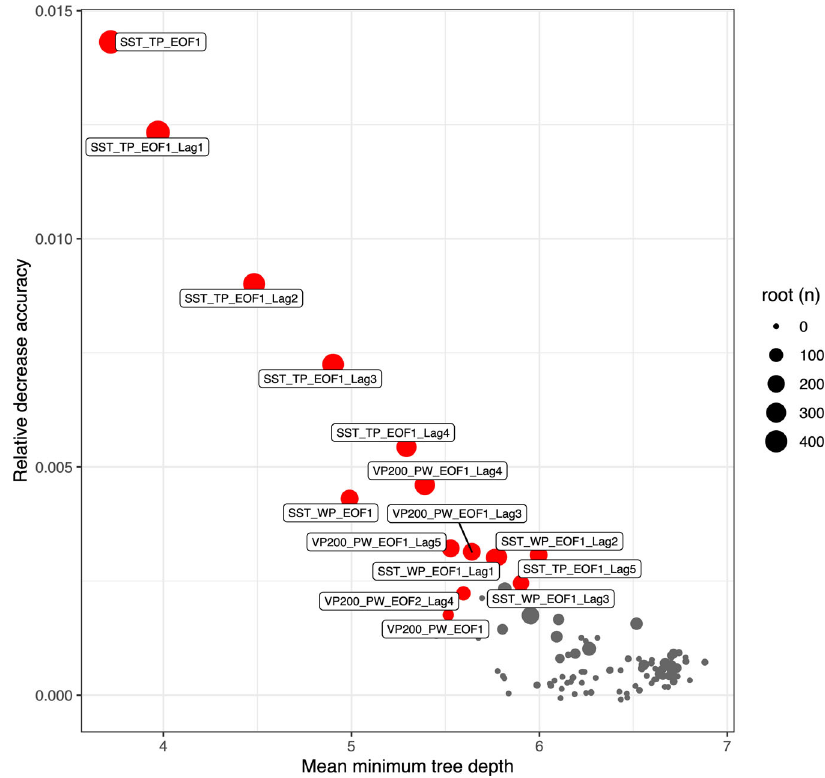
Fig. 5 Individual variable importance for the Random Forest model. Predictor variable importance plot for the Random Forest model predicting JFM clusters. Three factors were considered: (1) Relative decrease accuracy — the relative penalty to accuracy from shuf fl ing each predictor variable; (2) mean minimum tree depth — the average minimum depth of the predictor variable across all decision trees in the Random Forest; (3) root — the number of instances when the predictor variable is positioned at the root of the decision tree, summed across all decision trees in the Random Forest. The 15 most important predictor variables are highlighted in red. Predictor variable labels relate to those in Fig. 1a, b. For example, SST_TP_EOF1 is the fi rst EOF